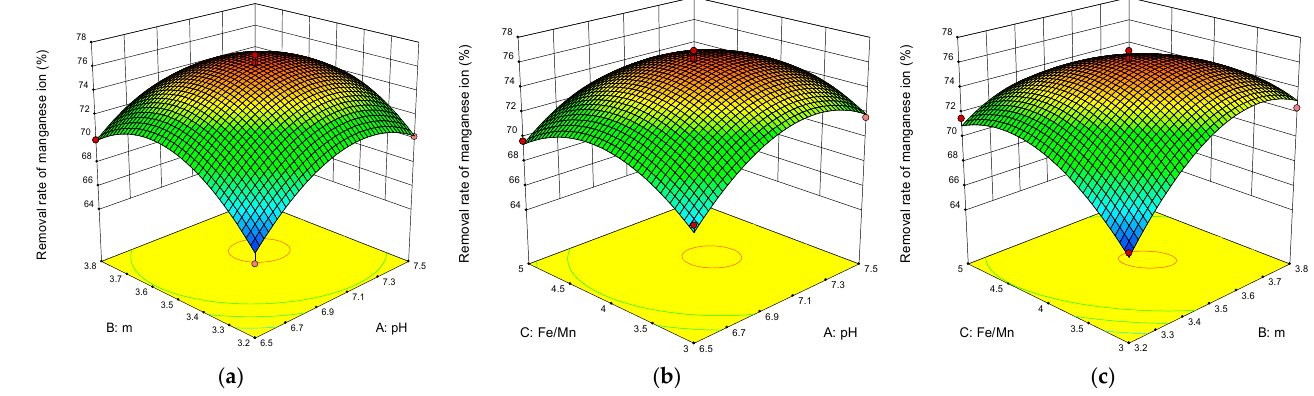
Figure 8. The 3D response surface diagram of manganese sand dosage and pH ( a ), initial concentration ratio of Fe/Mn and pH ( b ), initial concentration ratio of Fe/Mn and manganese sand dosage ( c ) influence manganese ion removal.